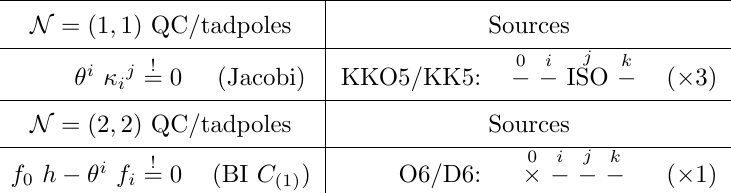
Table 3 . Non-vanishing QC (3.6), (3.8) and their higher-dimensional origin for the (cid:13)ux compacti(cid:12)- cation of massive type IIA with O6/D6 given in table 1, where BI stands for Bianchi identities and Jacobi refers to the condition in (2.10). A description of the QC as restrictions for the existence of additional local sources is